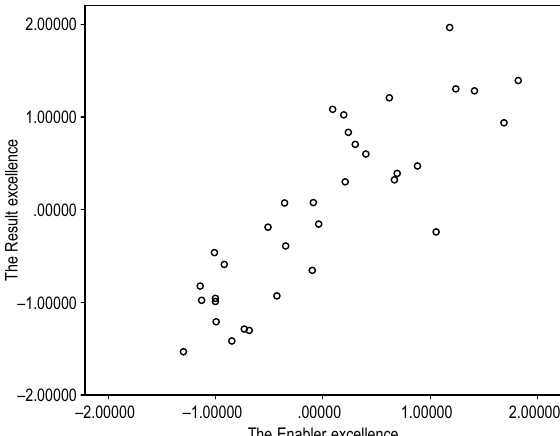
Fig. 2. Scatter plot of the Enablers and Results excellence factors